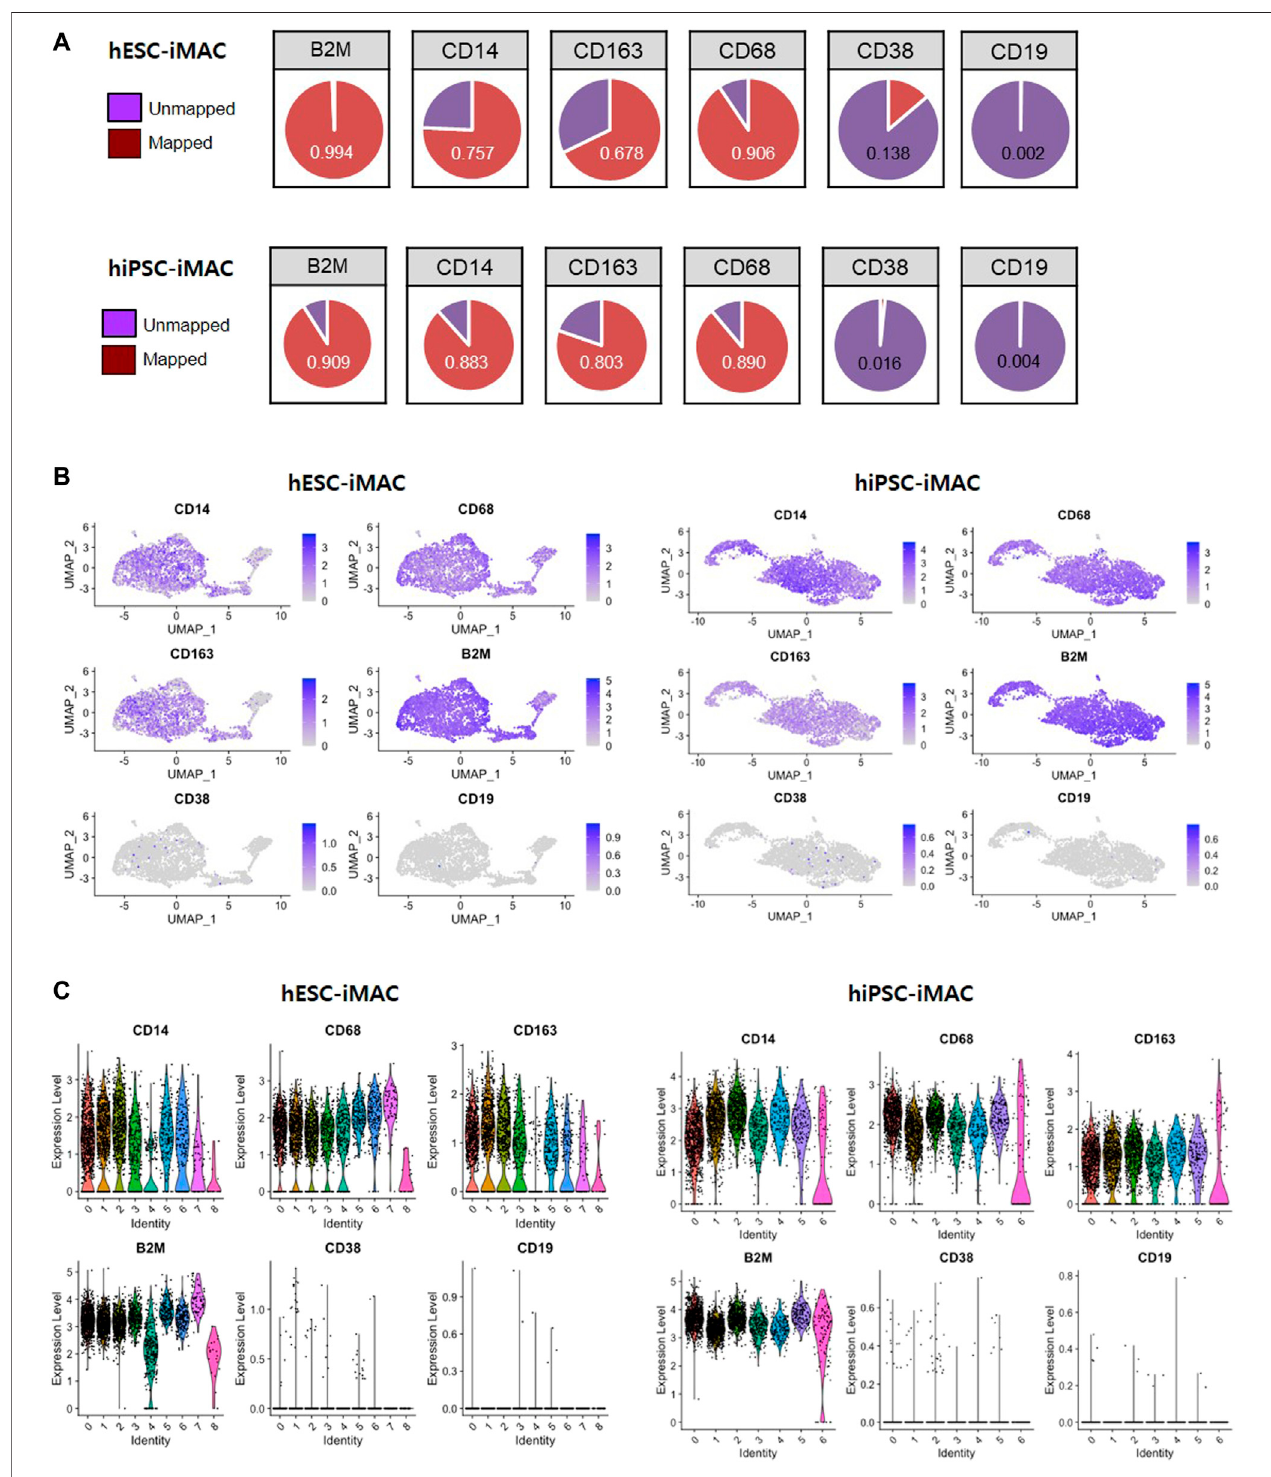
FIGURE 3 | Expression level of known macrophage markers analyzed by Seurat method. (A) The proportion of cells expressing macrophage-positive and macrophage-negative marker genes and the number of mapped genes. Violin and jitter plots and UMAP plots for the expression of (B) macrophage-positive markers (CD14, CD68, CD163, and B2M) and (C) macrophage-negative markers (CD38 and CD19).